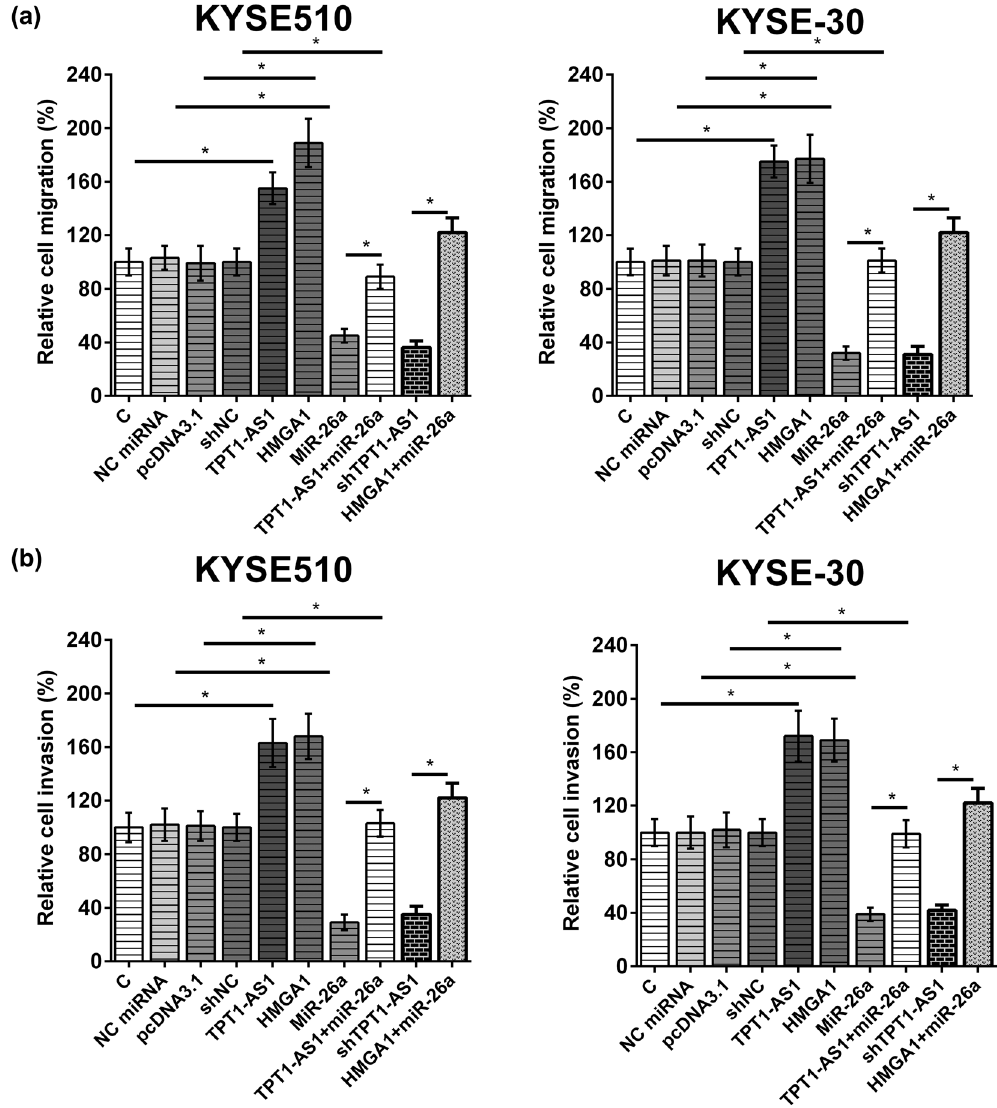
Figure 5: TPT1 - AS1 regulated the miR - 26a/HMGA1 axis to enhance KYSE510 and KYSE - 30 cell migration and invasion. ESCC cells migration ( a ) and invasion ( b ) abilities were determined by Transwell assays. *, p <